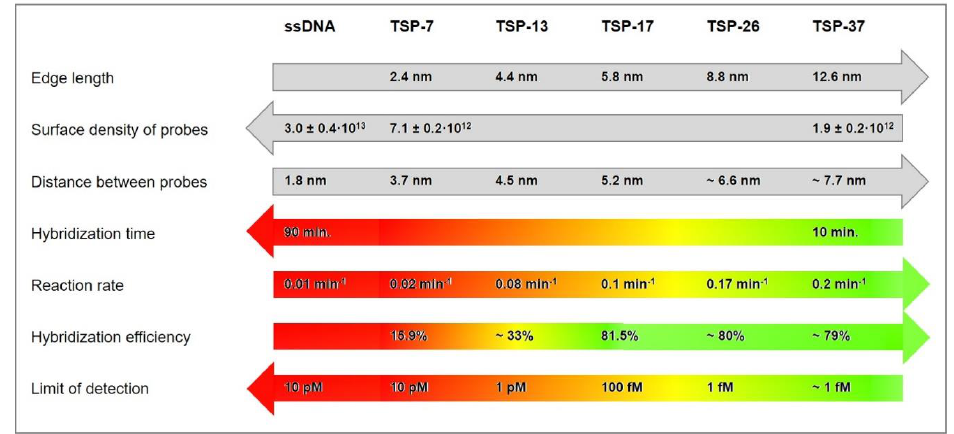
Figure 20. Characterization of DNA tetrahedrons of different sizes (the numbers refer to the base pairs of each edge of the tetrahedron) and comparison to directly immobilized ssDNA probe. Data taken from the authors of [140], estimated data (~) extracted from graphs. The color gradient intends to give a simple overview of general tendencies, whereby the red color was by no means meant to signify poor